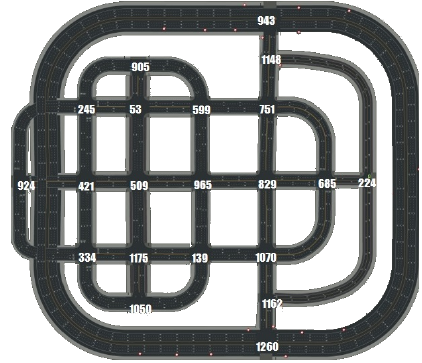
Figure 1. Map town 05 of Carla with junction